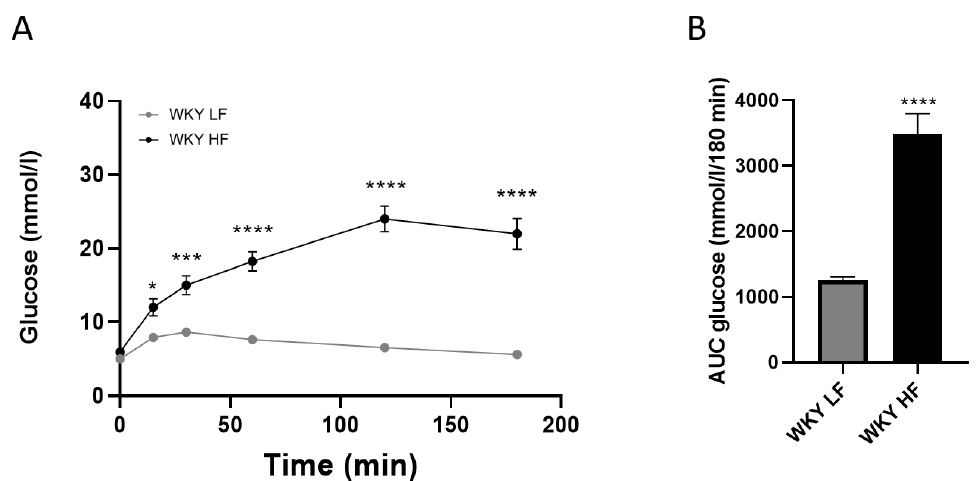
Figure 2. OGTT ( A ) and corresponding AUC ( B ) measured in WKY on LF diet and on HF diet before the treatment (60 weeks of age). Data are presented as means ± S.E.M. Statistical analysis was performed by t-test or two-way ANOVA with Bonferroni’s post hoc test. AUC area under the curve. Significance is * p < 0.05, *** p < 0.001, **** p < 0.0001 vs. WKY LF (n = 8).